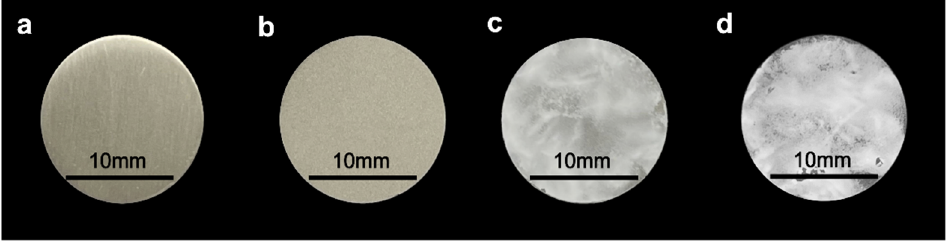
Figure 2. Gross appearance of ( a ) Ti, ( b ) blast-Ti, ( c ) α -tricalcium phosphate ( α -TCP)-Ti, and ( d ) hydroxyapatite (HA)-Ti discs.